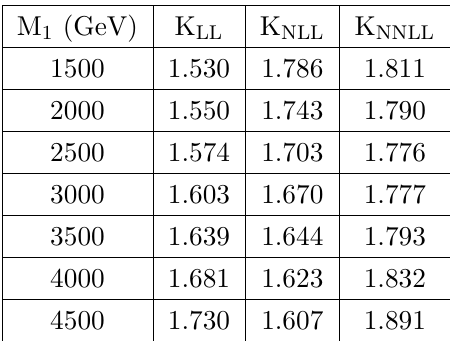
Table 5 . Resum K-factors for signal right at the resonance for di(cid:11)erent M 1 values are presented up to NNLO+NNLL in QCD for 13 TeV LHC.